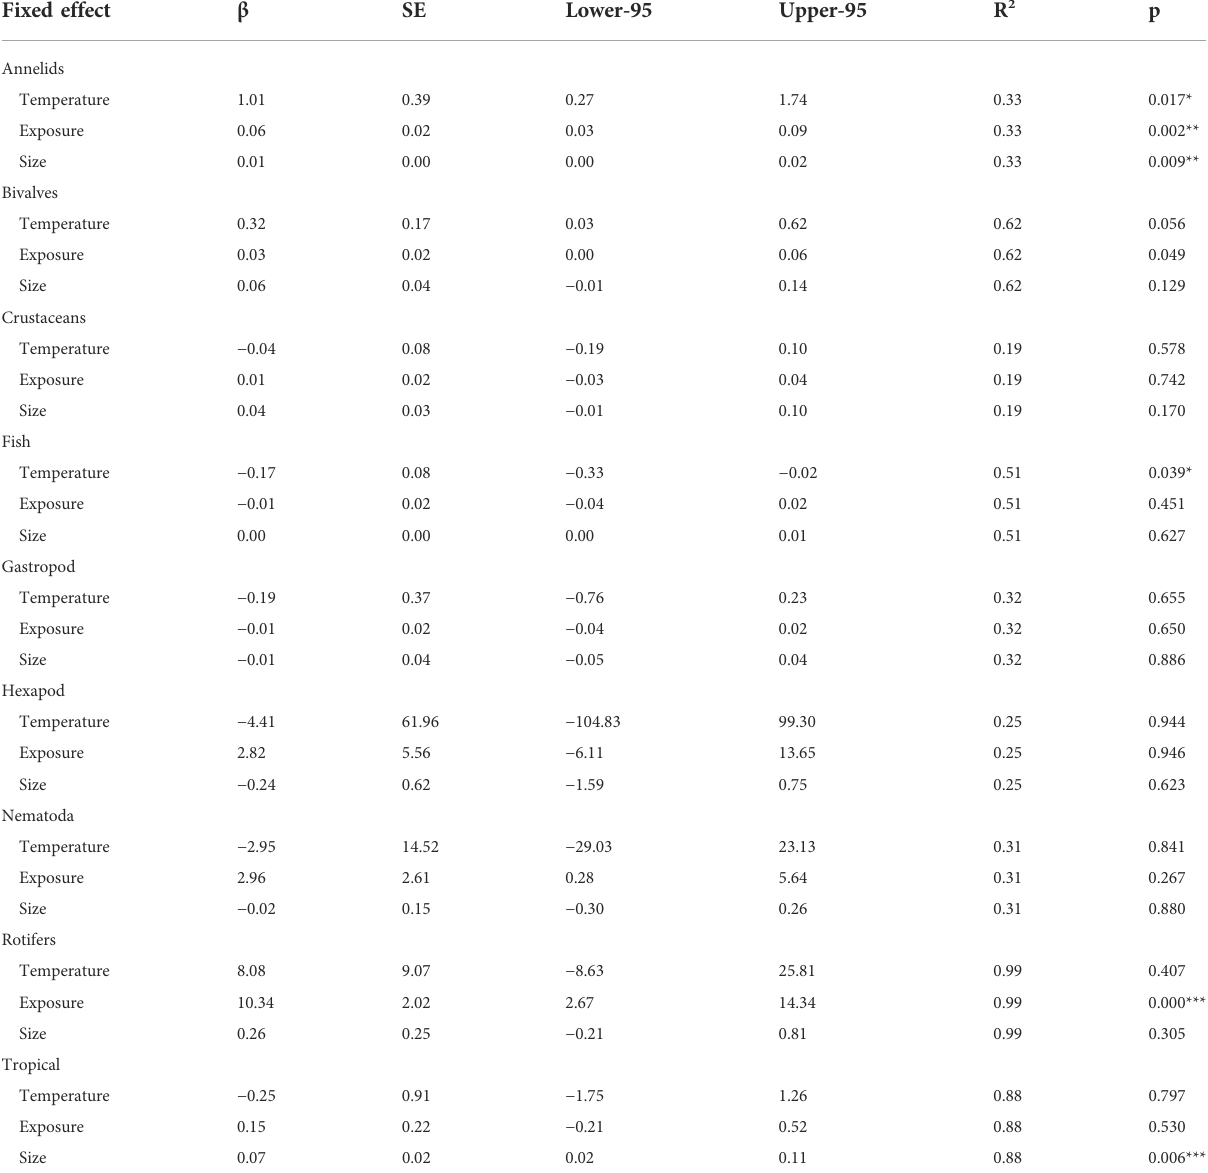
TABLE 3 Meta-regression analyses between effect size (dependent variable = Hedges ’ g of microplastic response) and three independent variables extracted from the literature (temperature in o C, maximum exposure in days, microplastic size in µm). Beta ( β ) represents the slope of the best fi t line.SErepresentthestandarderrorof β .Lower-95 andUpper-95representcredibilityintervals.R 2 denotestheproportionofthevarianceexplained by the regression model. p represents statistical signi fi cance. Asterisks signi fi cant effects for each species * p < 0.05, ** p < 0.01, *** p <